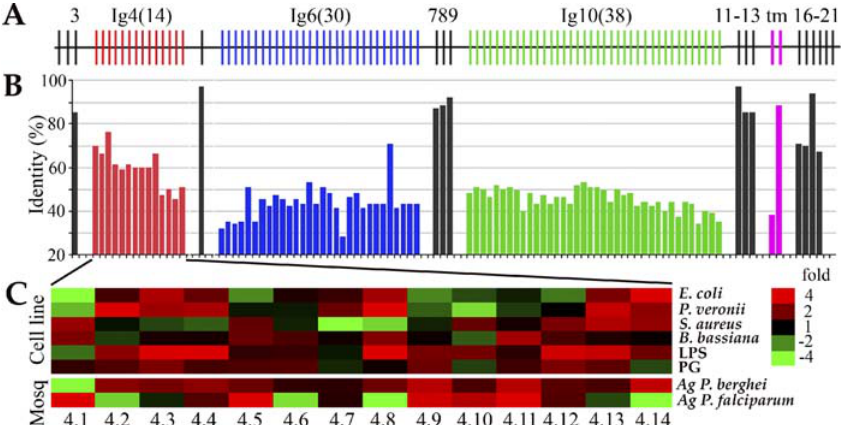
Figure 1. AgDscam Gene Organization and Infection-Responsive Splicing (A) The variable Ig domain exon cassettes 4, 6, and 10 are displayed as Ig4(14) (red), Ig6(30) (blue), and Ig10(38) (green), each containing 14, 30, and 38 exons, respectively. The transmembrane domain exons (tm) 11–13 are displayed in pink, and non-spliced exons are displayed in black. (B) Percentage identity of AgDscam exons to the D. melanogaster Dscam exons at the amino acid level is displayed. Phylogenetic relations between AgDscam Ig exons are presented in Figure S1. (C) Differences in AgDscam exon 4 transcript representations between bacterially- (E. coli, P. veronii, S. aureus), fungus- (B. bassiana), LPS-, and PG- challenged cell line Sua5B and a non-challenged cell line at 12 h after challenge, and Plasmodium- (P. berghei and P. falciparum) infected midguts (Mosq) and non-infected blood-fed midguts at 24 h after ingestion. The numbers ( ‘‘ 4.1 ’’ – ‘‘ 4.14 ’’ ) indicate the individual exons of exon cassette 4. Expression was determined with RTqPCR analyses in three replica assays. The fold difference in exon representation (ratio) between challenged and naive samples from three replicates were determined in normalized cDNAs, and expression ratios are displayed in a color scheme where red indicates a higher representation and green indicates a lower representation of exons in challenged samples compared to naı¨ve samples. Black was indicative of a lack of infection-responsive regulation. Normalization was done with expression analysis of a non-spliced AgDscam exon and a ribosomal S7 gene. The significance of variable exon regulation at a 95% confidence level, the RTqPCR efficiencies for each pair of exon primers, expression data values, and standard errors are presented in Table S1. DOI: